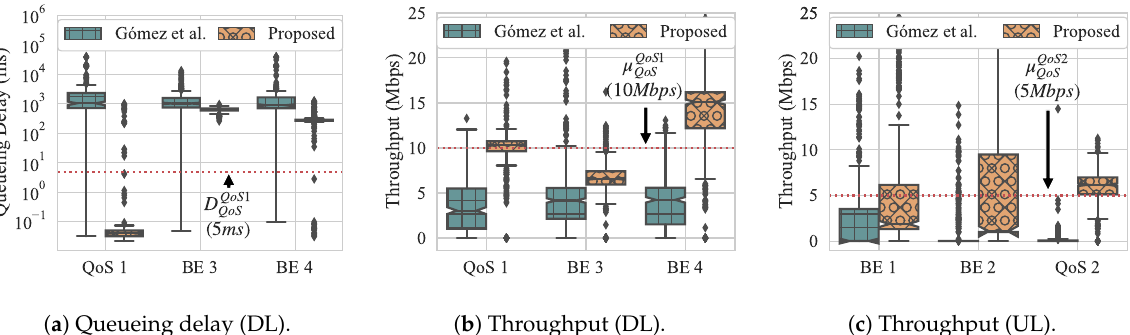
Figure 17. Experiment 3 box-and-whiskers plots. ( a ) Queueing delay of slices (DL); ( b ) throughput of slices (DL); ( c through- put of flows from STAs